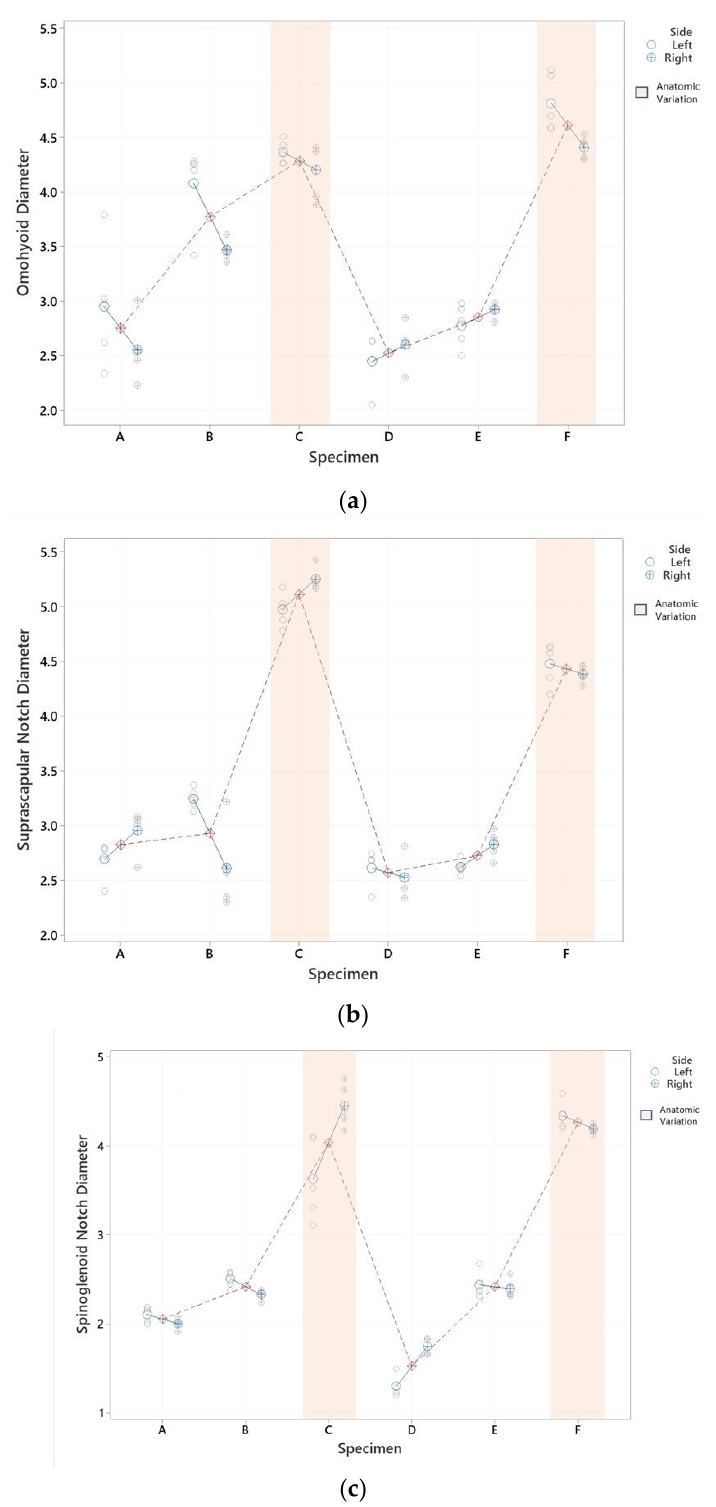
Figure 3. SNe diameter graphical representation by specimens. ( a ) SNe diameter graphical representation by specimens at OHlv; ( b ) SNe diameter graphical representation by specimens at SNolv; ( c ) SNe diameter graphical representation by specimens at SGNlv. Differences between specimens (each red point is the mean of its diameter) are represented in OHlv ( a ), SNolv ( b ), and SGNlv diameters ( c ). Differences between sides (each blue point is the mean of left and right sides), as well as the effect of the AV (marked in orange), were observed in 5 measurements.